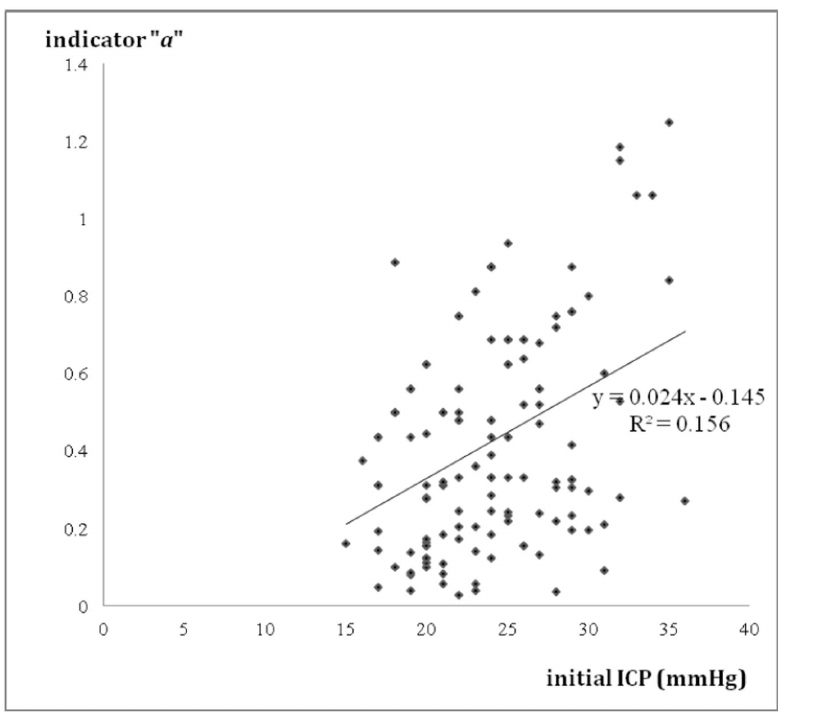
Fig 1. Relationship between initial ICP and the indicator "a" in parabolic equations. N = 139. Regression line is shown; regression equation: y = 0.024x-0.145; R 2 = 0.156.